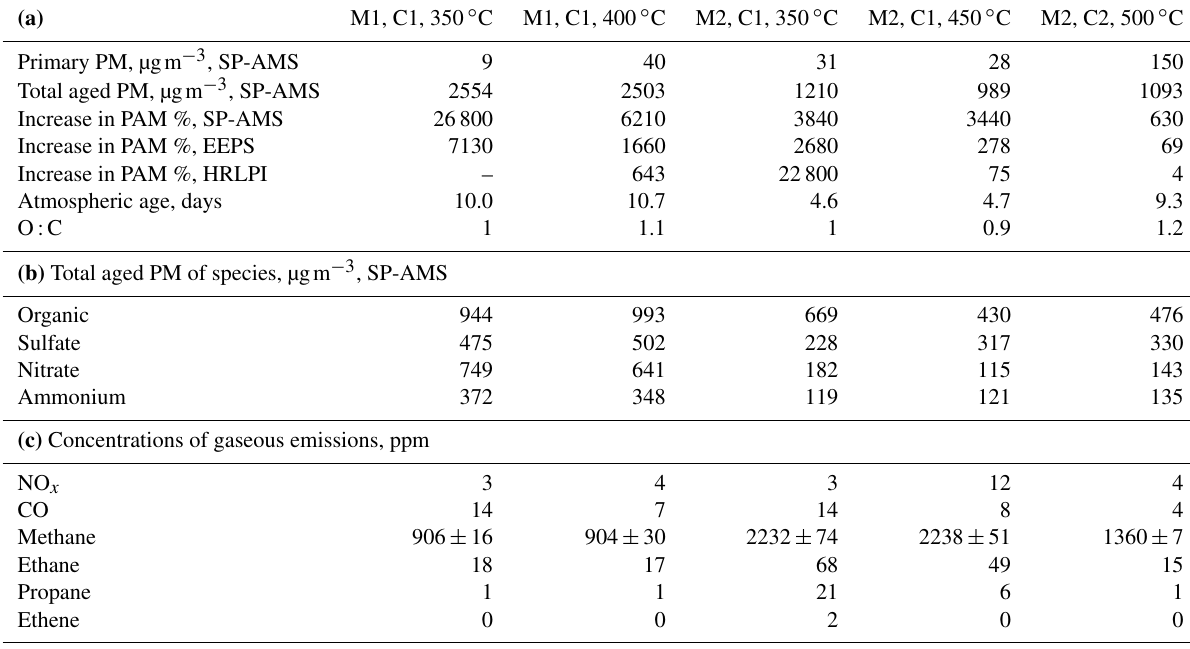
Table 1. (a) Particle mass concentrations of primary and total aged particles (SP-AMS), increase of particle mass (%) in PAM chamber, calculated atmospheric ages simulated by PAM chamber and O:C ratios measured by SP-AMS. If no increase in PAM is presented, it is larger than 100 000%. (b) The particle mass of species (SP-AMS) in all cases is also presented in the table as well as (c) the concentrations of gaseous emissions in raw exhaust (published already in Lehtoranta et al., 2017). Values have been corrected by the dilution ratio used in the sampling system.